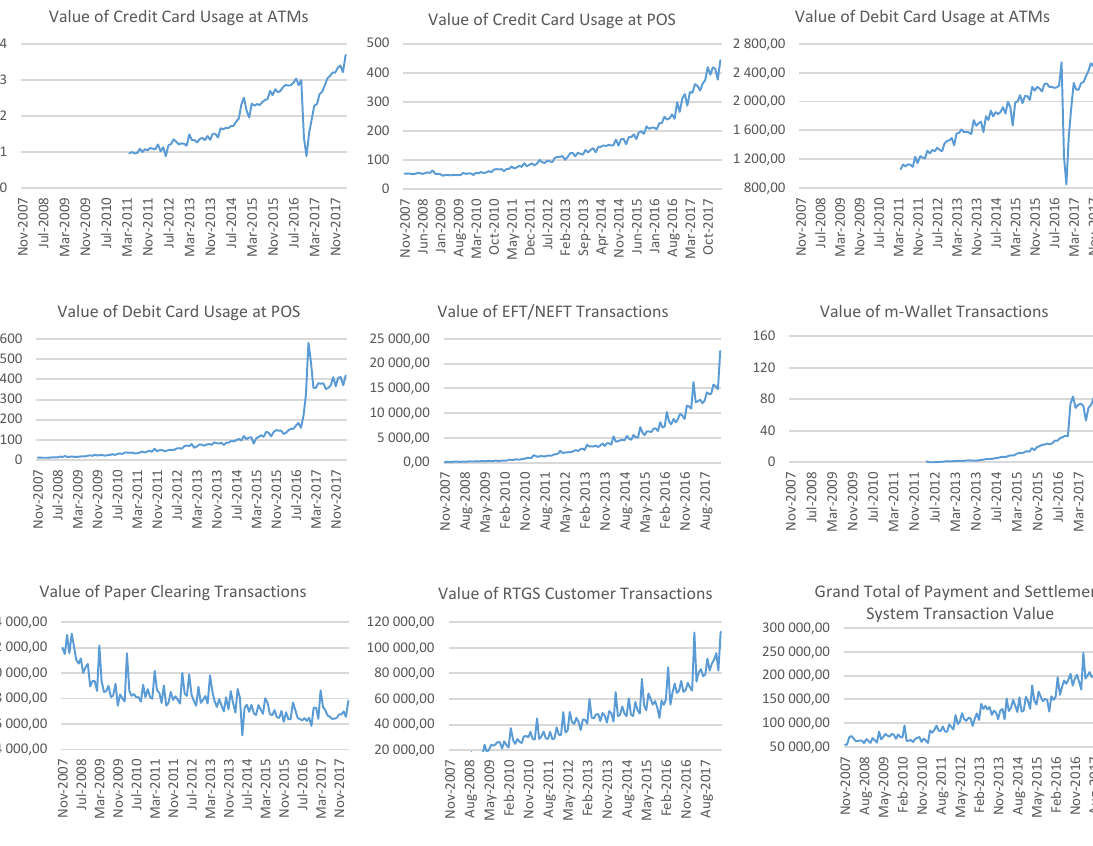
Figure 2. Trends in the value of transactions in the payment and settlement system indicators selected for the